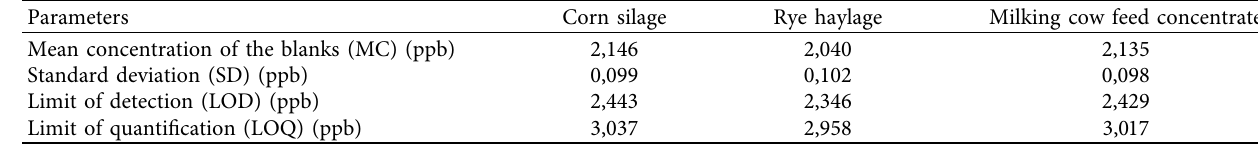
Table 2: Calculated ELISA data for the limit of the detection and quantification with Romer AgraQuant ® aflatoxin B1 ELISA test kit ( n � 8). Parameters